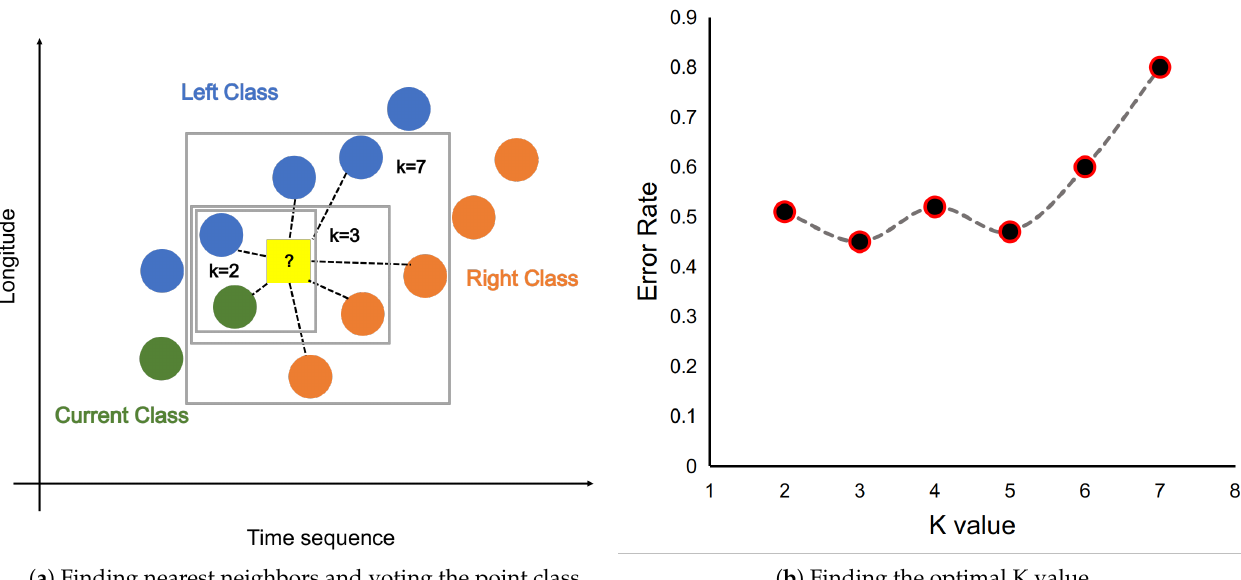
Figure 6. Schematic diagram of the process of obtaining the number of neighbors: ( a ) finding nearest neighbors and voting the point class and ( b ) finding the optimal K value in